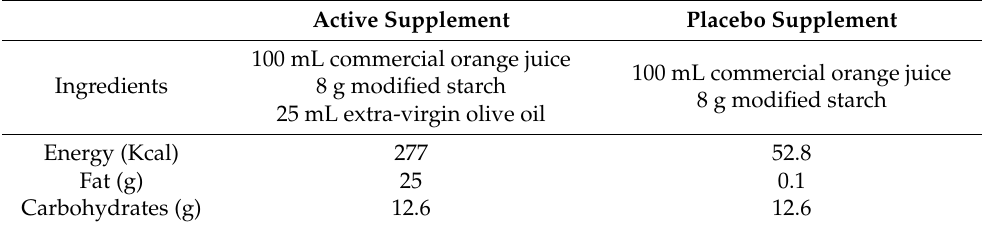
Table 1. Supplement ingredients and nutritional